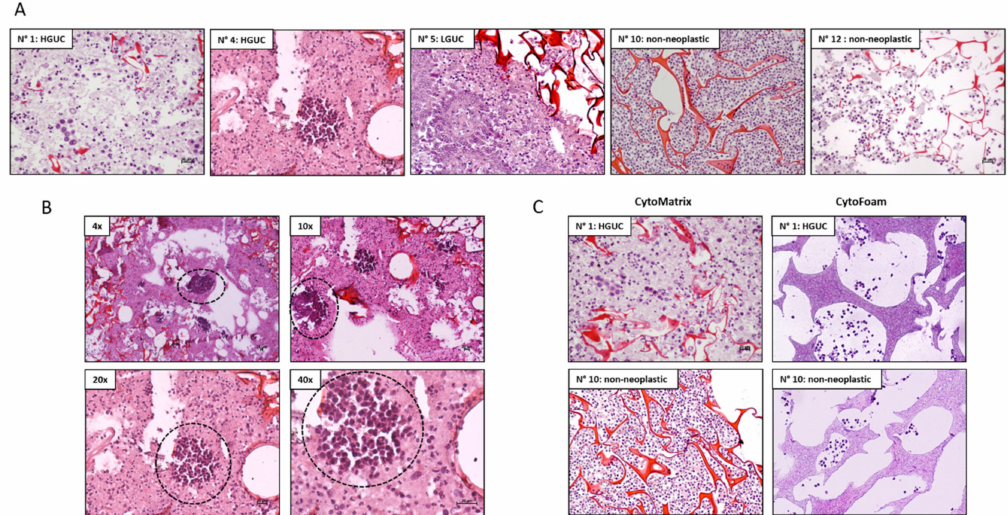
Figure 2. H&E staining of CytoMatrix-FFPE blocks. ( A ) Panel of H&E at magnification 20x from different representative cases diagnosed as HGUC, LGUC or non-neoplastic. ( B ) H&E of CytoMatrix-FFPE N ◦ 4 shows the presence of a papillary cluster (circle in black) with neoplastic cells characterized by large and hyperchromatic nucleus, increased nucleus/cytoplasm ratio, and nuclear pleomorphism (at magnification 4 × , 10 × , 20 × and 40 × ). ( C ) Comparison of H&E of samples N ◦ 1 and N ◦ 10 obtained from CytoMatrix-FFPE or CytoFoam (at magnification 20 × ); CytoMatrix clearly shows an increase in the number of cells and the presence of a “tissue-like”